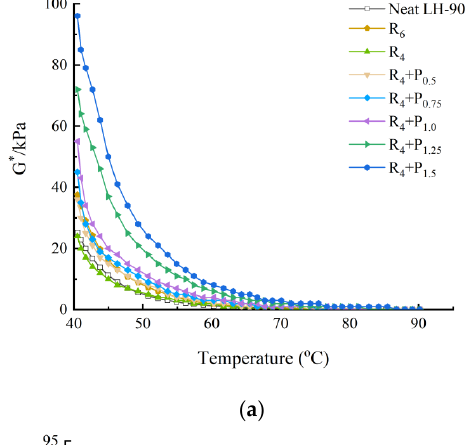
Figure 3. High-temperature properties of compound ratio of PPA – SBR and DH – 70# neat asphalt: ( a ) Complex modulus-temperature results; ( b ) Phase angle-temperature results; ( c ) G*/sinδ -tenper- ature results.